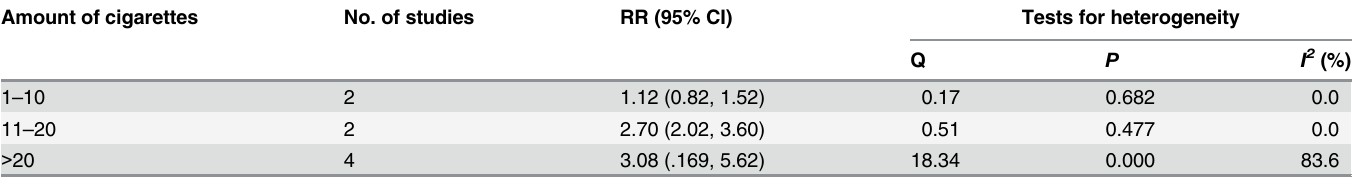
Table 4. Relative risk (RR) and 95% confidence interval (95% CI) for categories based on daily cigarette consumption. Amount of cigarettes No. of